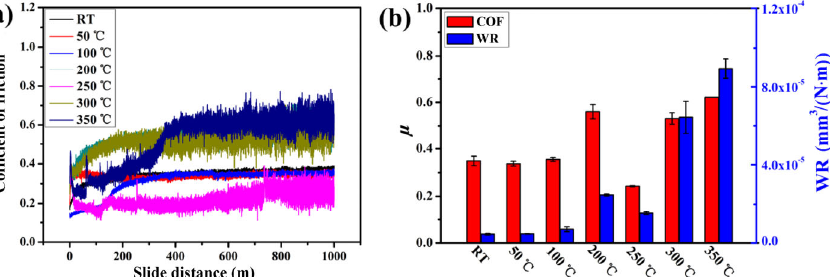
Fig. 3 The measurements for COF and WR of TPI-1: (a) COF as function of sliding distance, (b) the average of COF and WR at different temperatures.